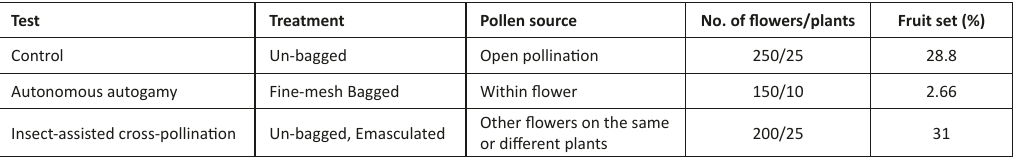
Table 1. Results of breeding experiments on Derris